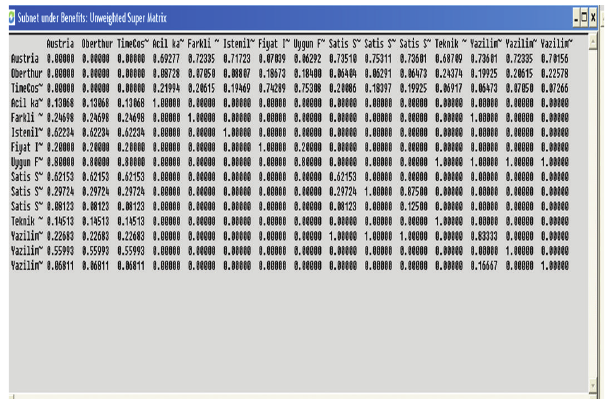
Figure 8: Unweighted super matrix.